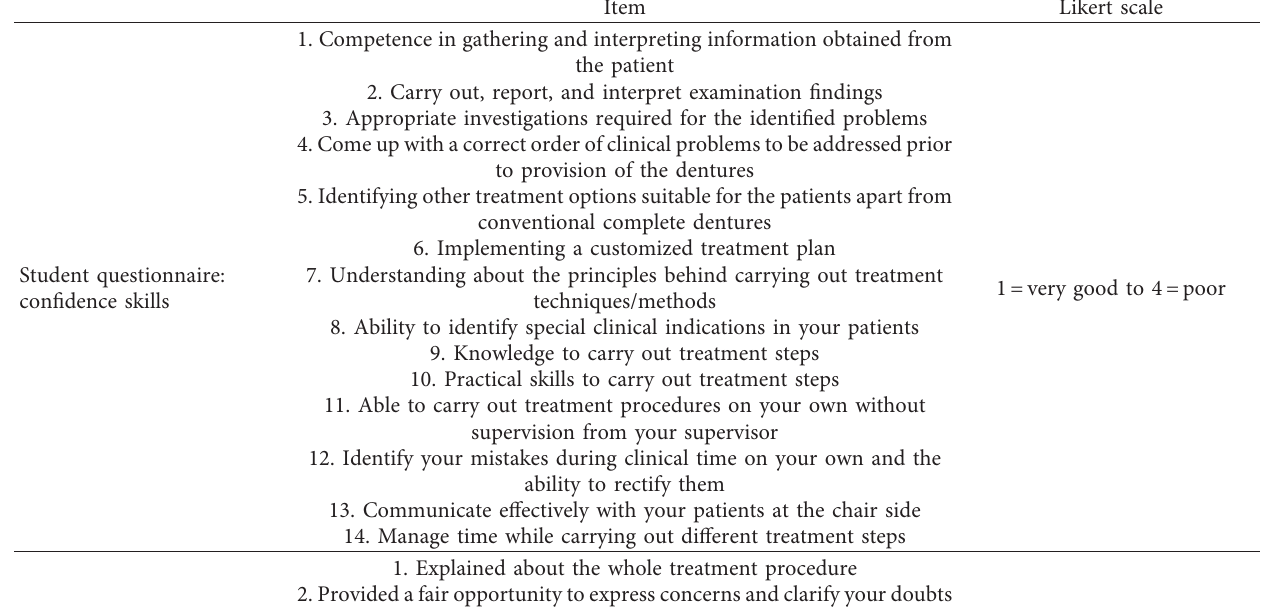
Table 1: Questionnaire showing the Likert scale for the level of confidence of students, level of satisfaction of patients, and clinical outcome of